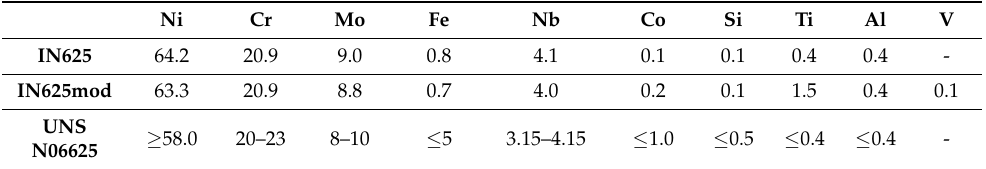
Table 1. EDS analyses of the IN625 and IN625mod alloys (chemical elements in wt.%) compared to the main chemical elements of the IN625 (UNS